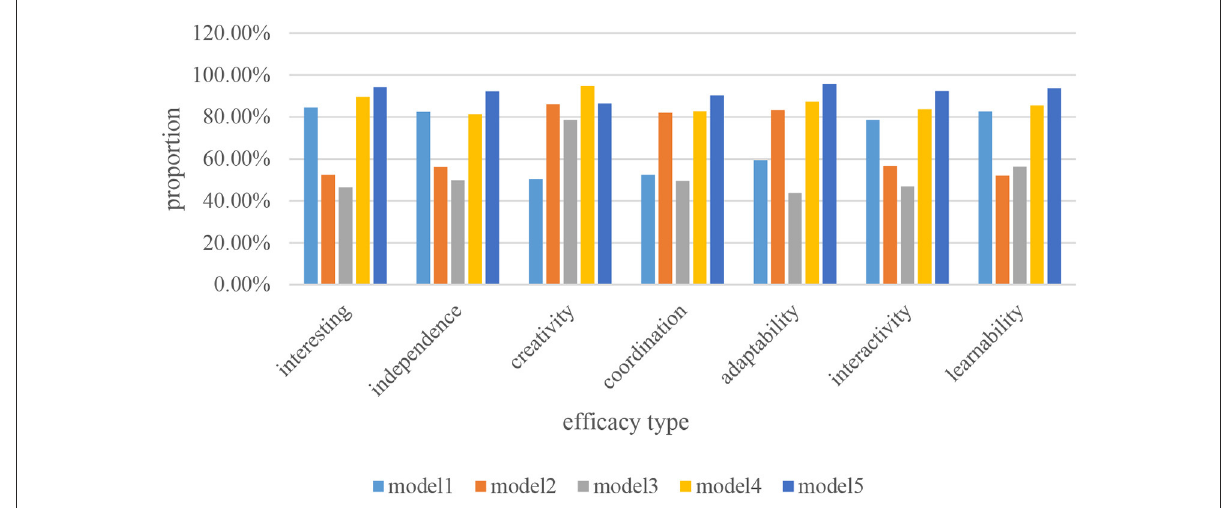
FIGURE8 Comparative analysis of effectiveness between different teaching